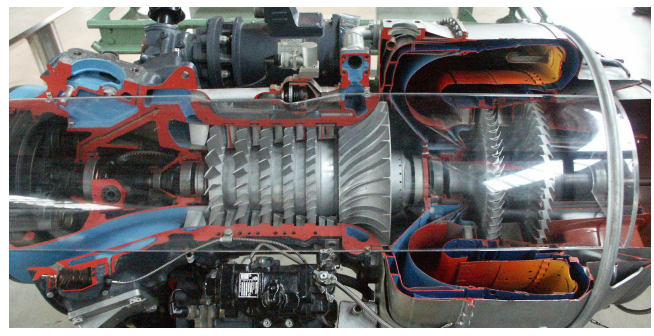
Figure 1. A gas turbine.